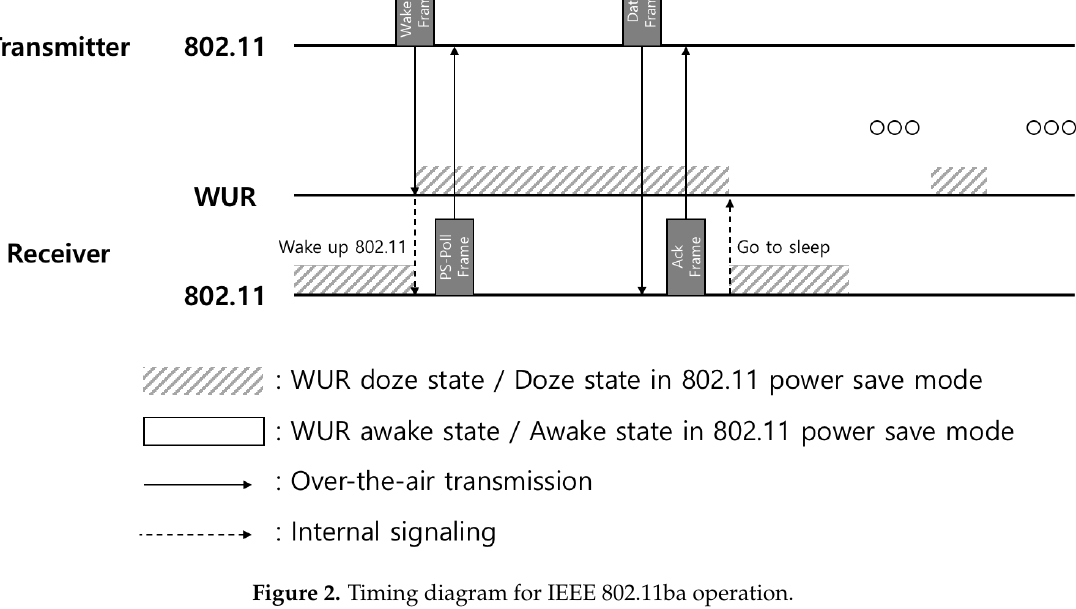
Figure 2. Timing diagram for IEEE 802.11ba operation.